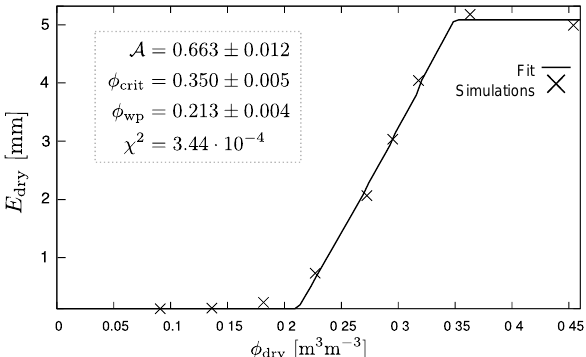
Figure 8. Fit of E dry with values obtained from the simulations of the default configuration ( DA_20_100 to DA_100_100 ). Crosses indicate values obtained from simulations while the line indicates the fit performed using Eq. (4). The upper left inset shows the values obtained by the fit together with absolute errors and the residual sum of squares χ 2 , i.e., the sum of the squared difference between the values predicted by the fit and the ones obtained in the